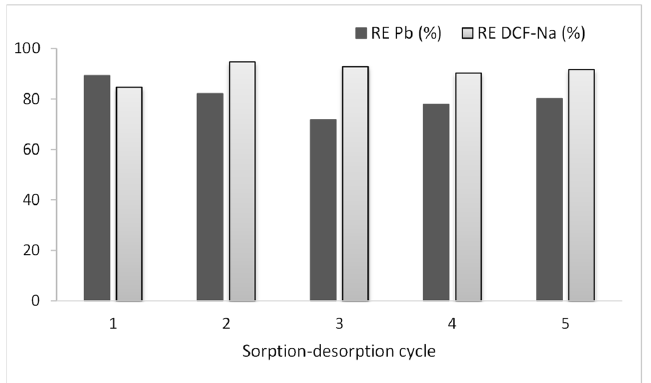
Figure 9. Removal e ffi ciency (RE) of the pollutants in consecutive adsorption-desorption cycles. Figure 9. Removal efficiency (RE) of the pollutants in consecutive adsorption-desorption